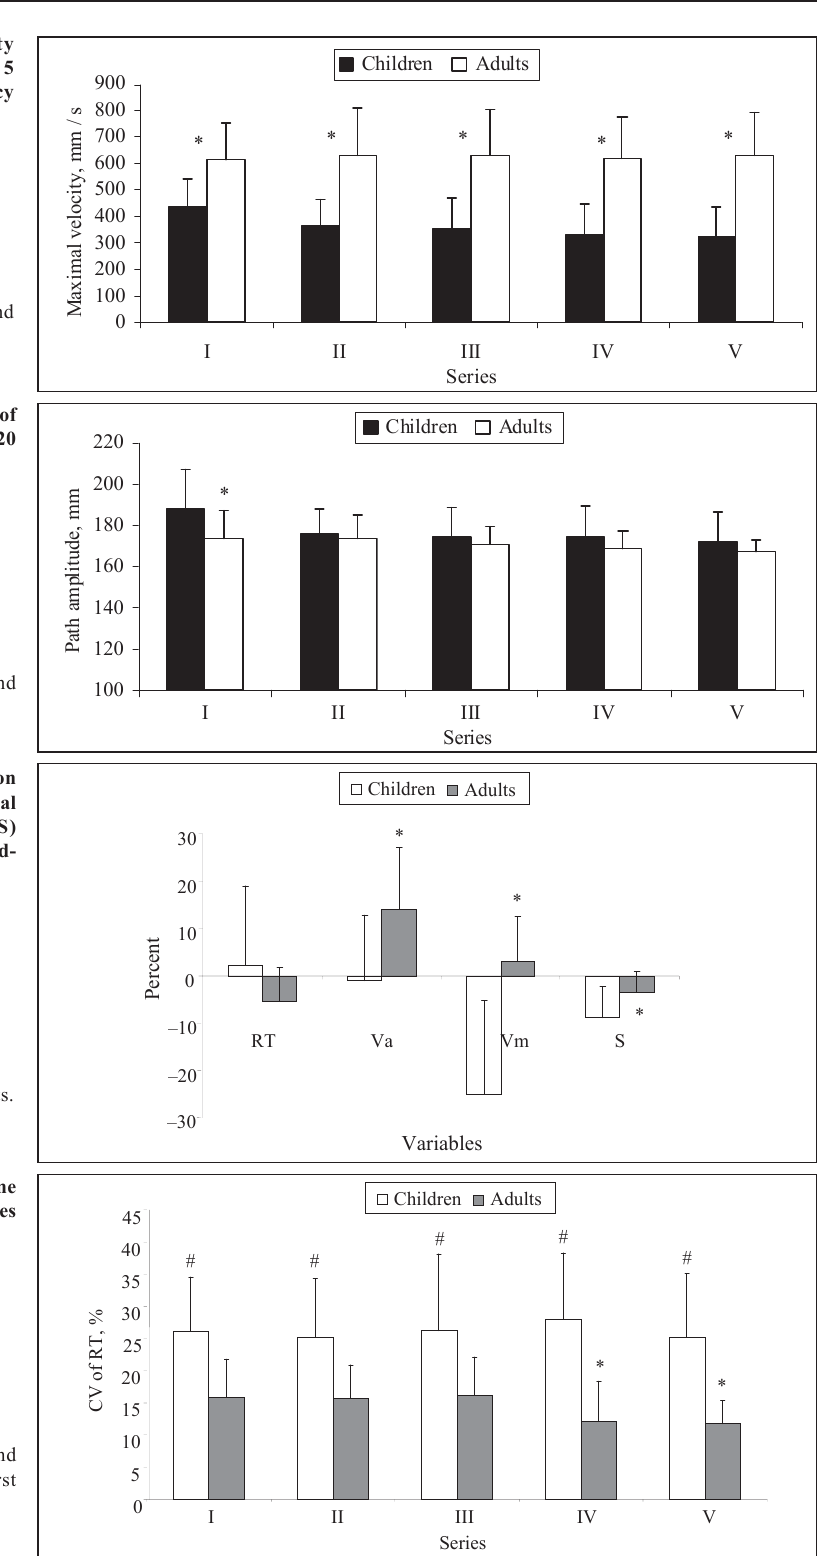
Note. # – p < 0.001 between children and adults; *– p < 0.05, compared to the first